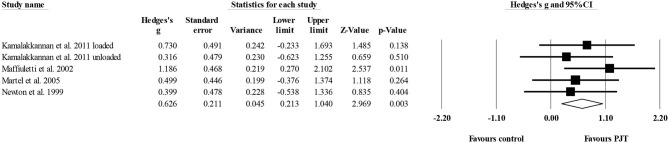
Forest plot of changes in countermovement jump with arm swing performance in volleyball players participating in plyometric jump training (PJT) compared to controls. Values shown are effect sizes (Hedges's g) with 95% confidence intervals (CI). The size of the plotted squares reflects the statistical weight of the study.